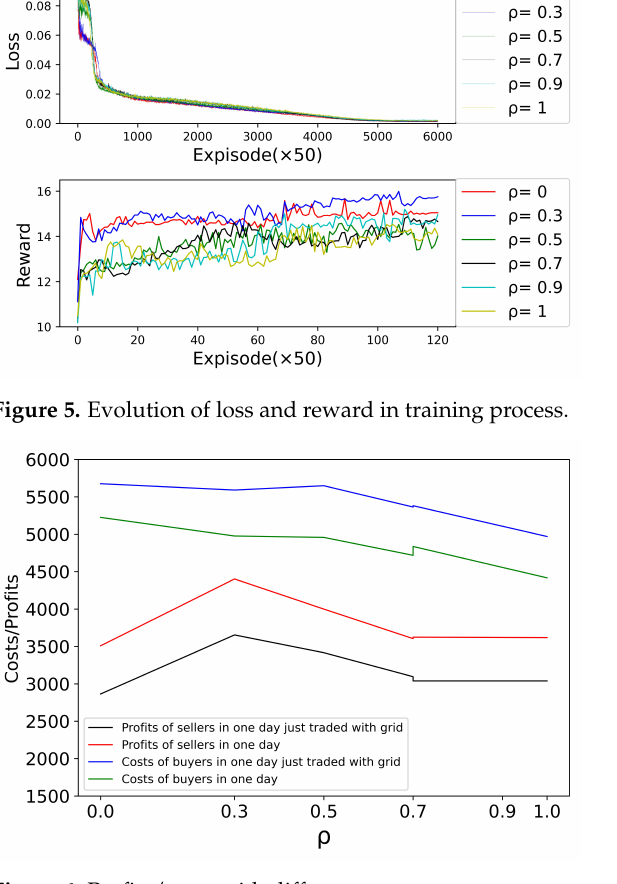
Figure 6. Profits/costs with different ρ